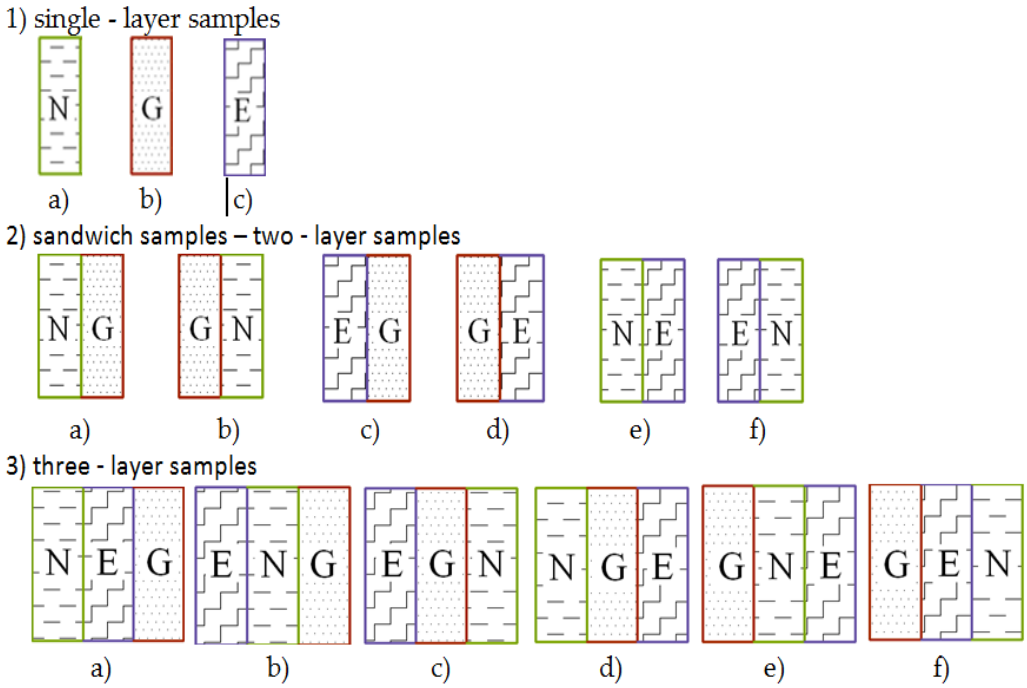
Figure 9 Test samples: N ‐ Nobasil; E ‐ Ekomolitan; G ‐ Recycled Rubber. Figure 9. Test samples: N—Nobasil; E—Ekomolitan; G—Recycled